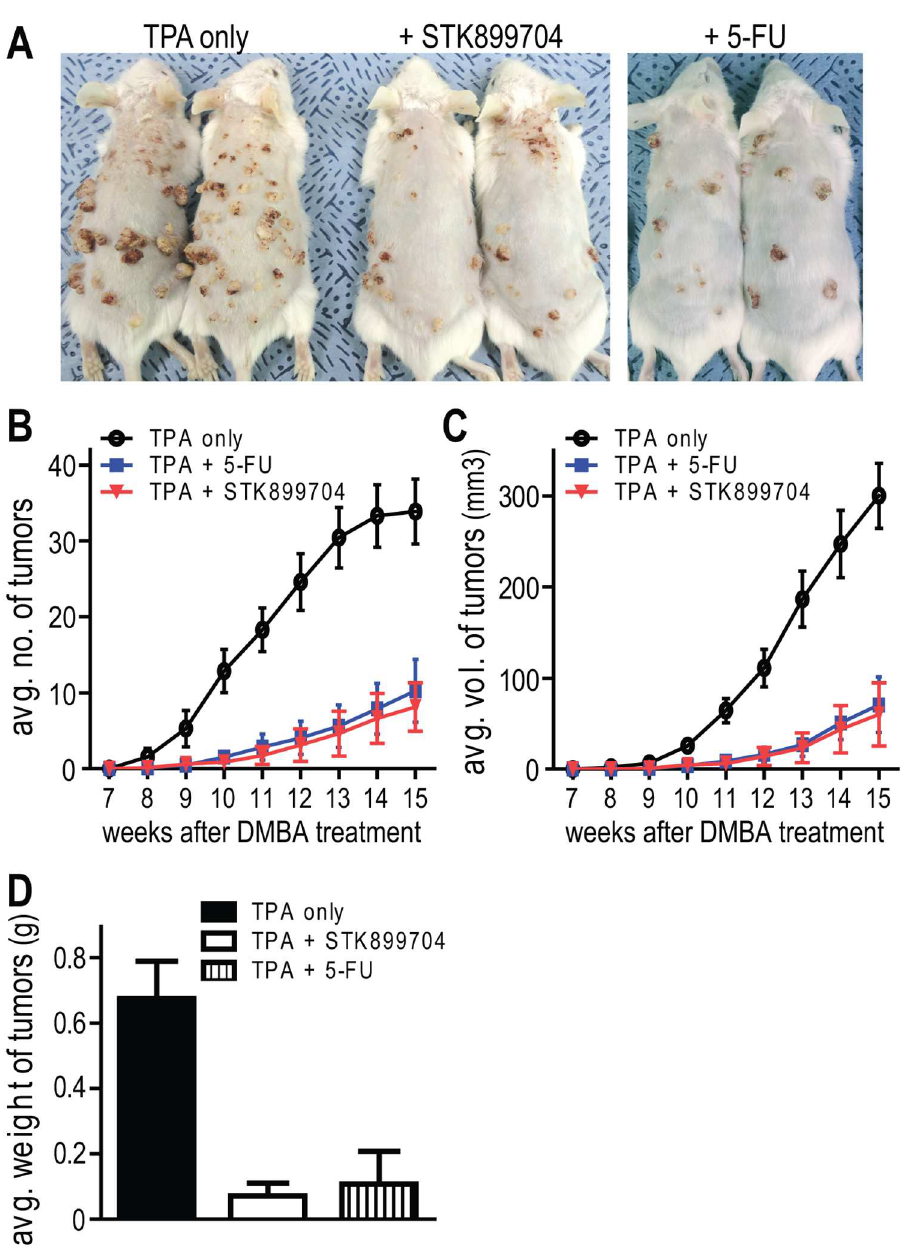
Fig 5. The antitumor activity of STK899704 in vivo carcinogenesis model. After tumor initiationby DMBA treatment, mice were further subjectedto TPA challengefor tumor promotiontwice a week. Either STK899704 or 5-fluorouracil (5-FU) was appliedtopically 30 minutes after TPA treatment for 15 weeks. (A) The tumor development and growth were assessedduringSTK899704or 5-FU treatment and comparedto TPA-treated control group at 15th week. Average number (B) and volume (C) of skin tumors per group were weeklyrecordedand calculatedduringtreatment. (D) Average weight of tumors was measuredin each group of mice at the end of the experiment. Error bars show mean ± SDs for each group of mice.